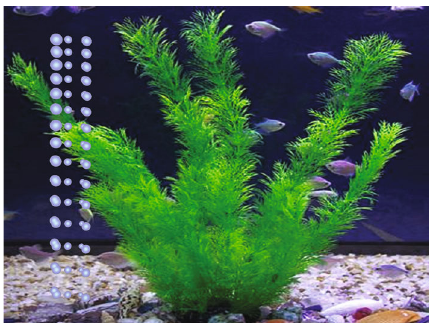
Figure 8: Coalescence of multiple 3D bubbles merging to an underwater